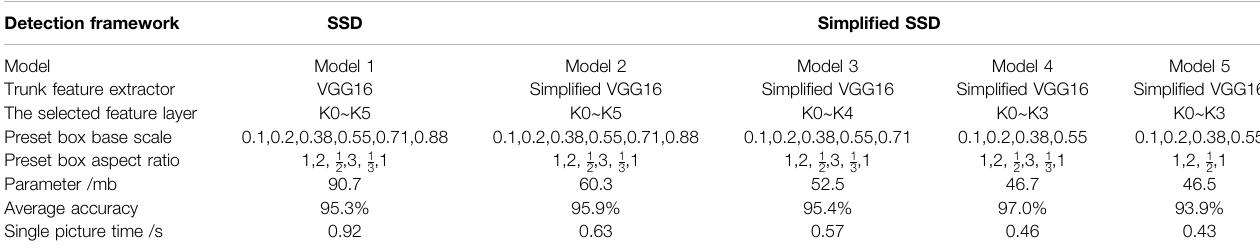
TABLE 2 | Experimental results of sample plot 1 under different SSD parameters. Detection